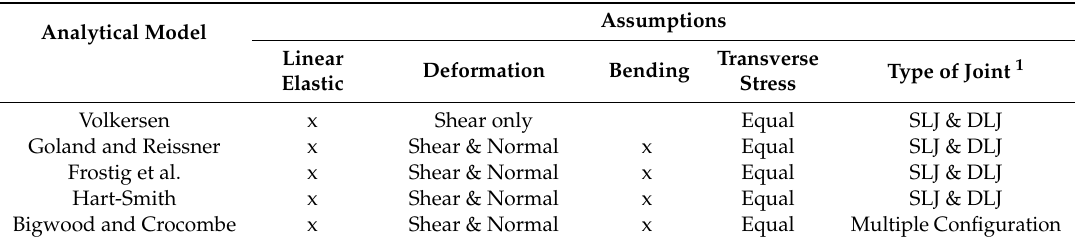
Table 1. Summary of common bond shear analytical models and their common assumptions [21].